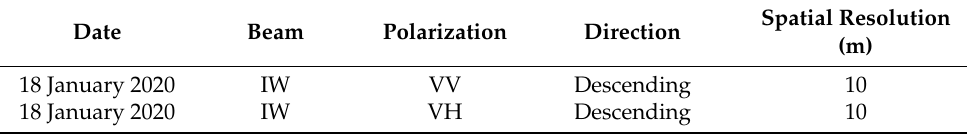
Table 3. Parameters of the Sentinel-1A